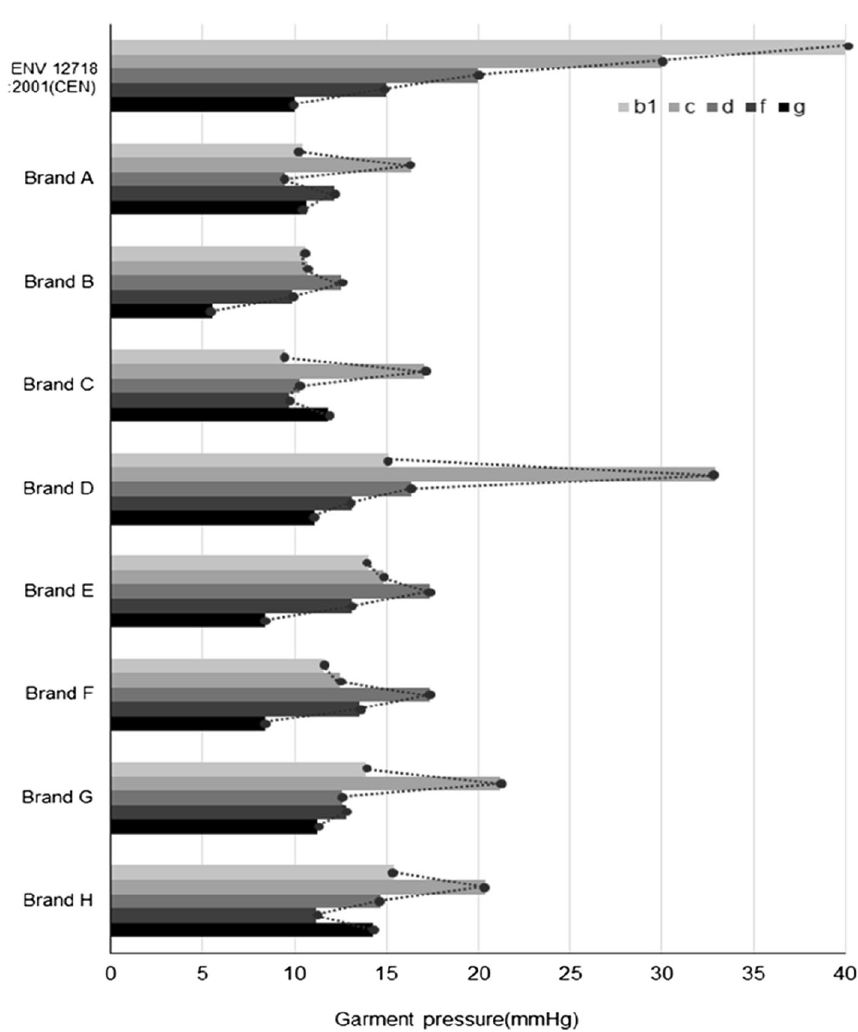
Fig. 3 Clothing pressure by brands. *ENV 12718 (ENV, 12718:2001, 2001): Comité Européen de Normalisation, adopted European prestandard pressure classes for Medical compression